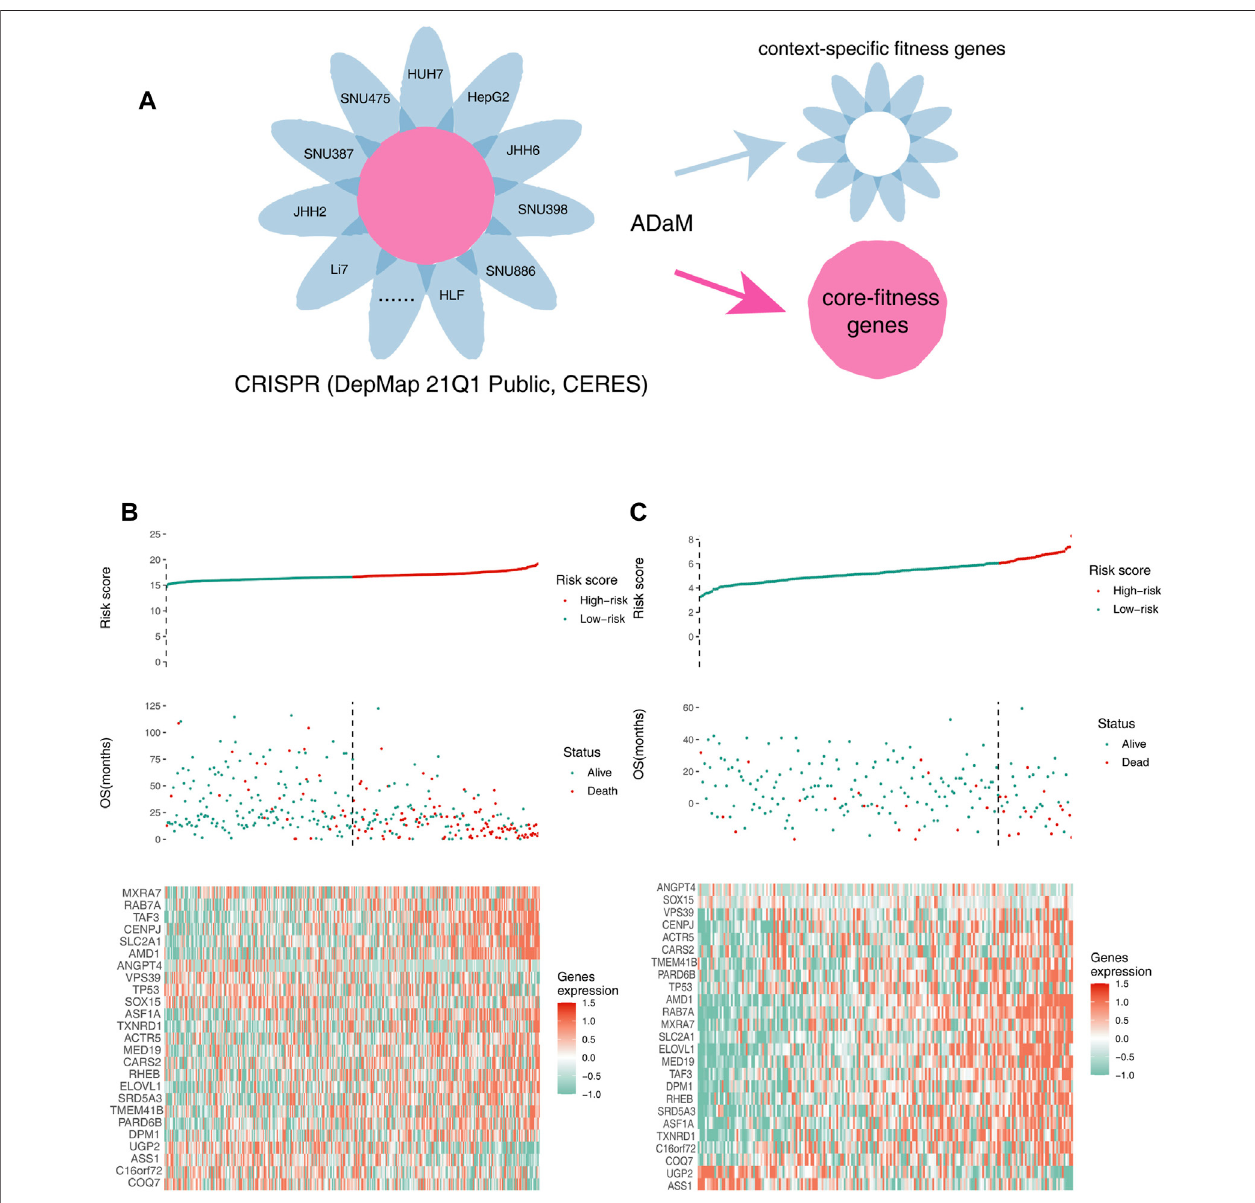
FIGURE 2 | Identifying context-speci fi c fi tness genes in liver cancers using the ADaM. (A) ADaM distinguished context-speci fi c fi tness genes from core fi tness genes to select potential targets for liver cancers. (B,C) The top graphs show the distribution of risk scores, the center graphs show the survival status of patients in the training and validation cohorts, and the bottom graphs show the expression patterns of the 25 genes. (B) TCGA training cohort and (C) ICGC validation cohort.